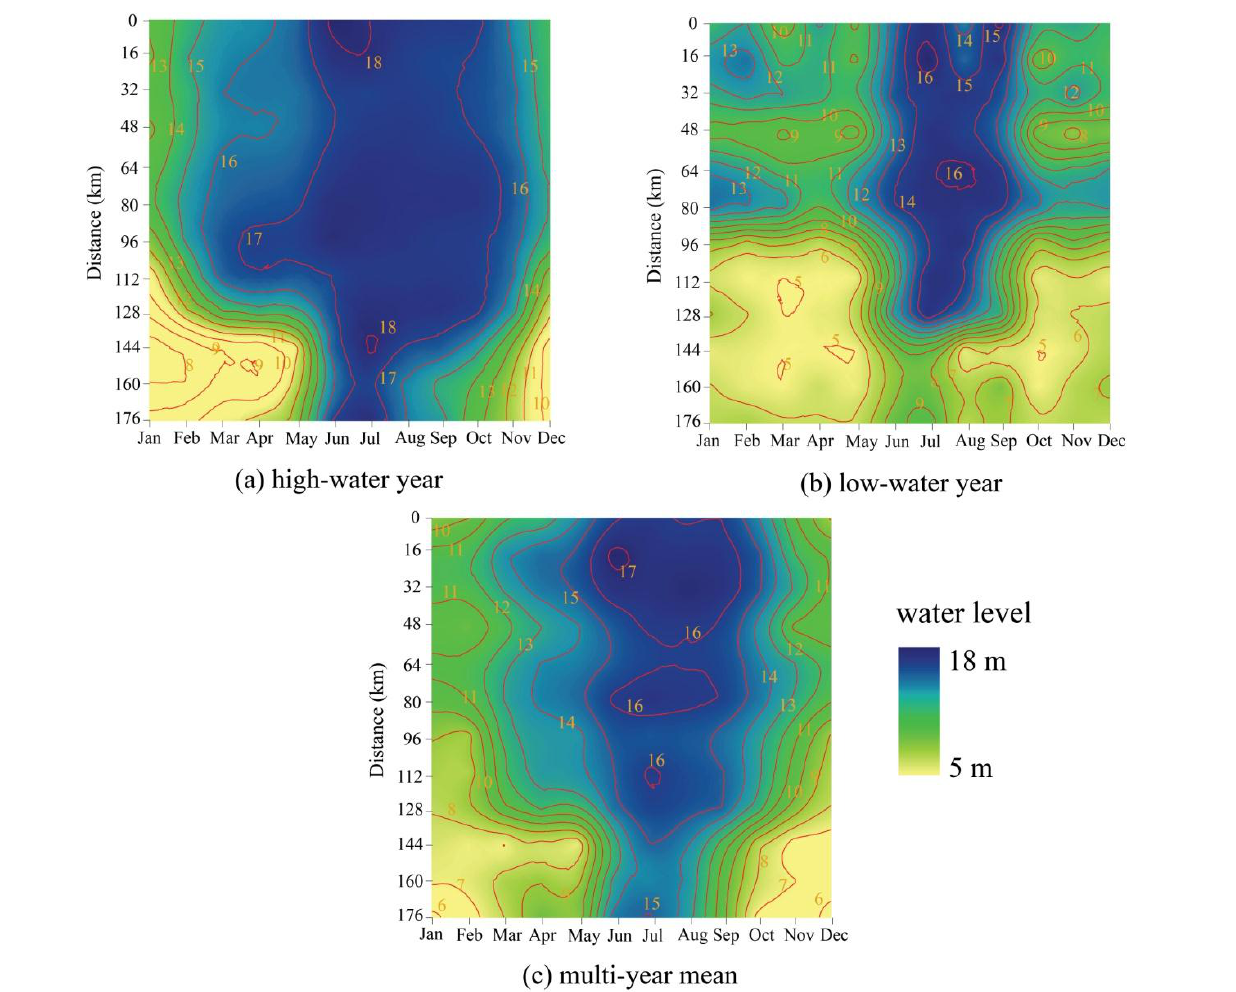
Figure 1. The water level along this profile was first extracted from the water level distribution maps at a sample interval of 1 km. Then, the extracted values were interpolated to a spatially-averaged water level evolution map from January–December. Figure 8 shows variation patterns of spatially-averaged water levels for three typical water years.